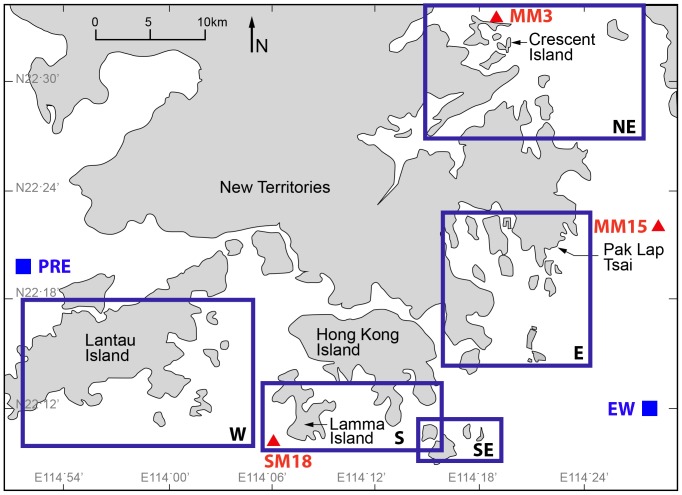
Map of the Hong Kong marine environment, including the Pearl River Estuary (PRE) to the west.Boxes (NE, E, SE, S and W) are regions of similar coral communities previously identified [8], [12]. Coral coring sites (Lamma Island, Pak Lap Tsai and Crescent Island) from the three regions with long-lived coral species are marked (red circles). Environmental Protection Department (EPD) hydrographic sites used in this study are identified (red triangles). The Pearl River Estuary (PRE) and eastern open ocean waters (EW) end member sites are shown (blue squares) [39].